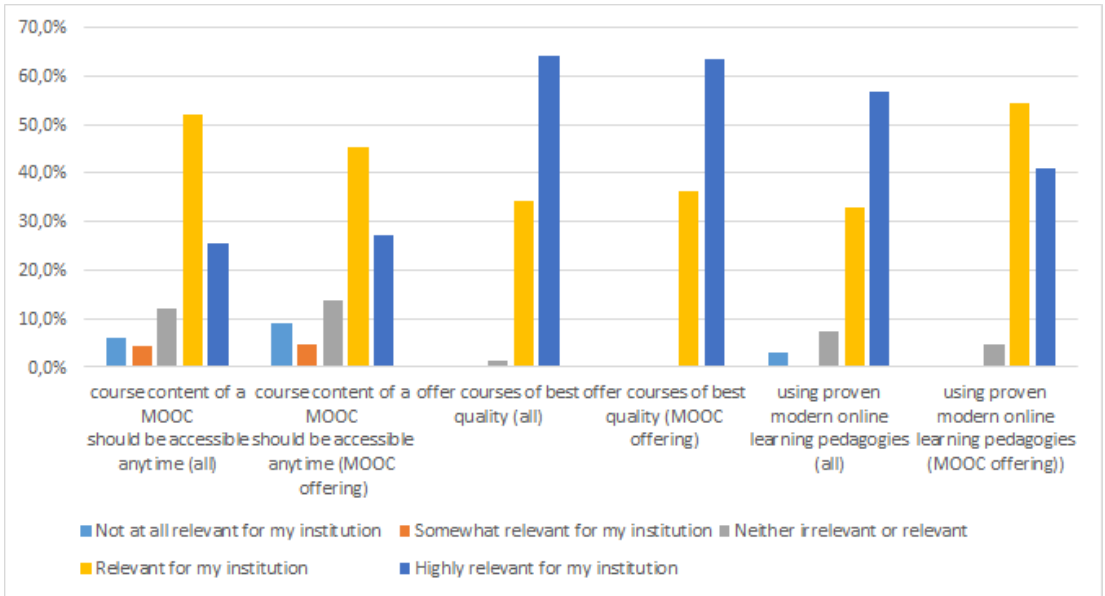
Figure 12 . The importance of the course component in